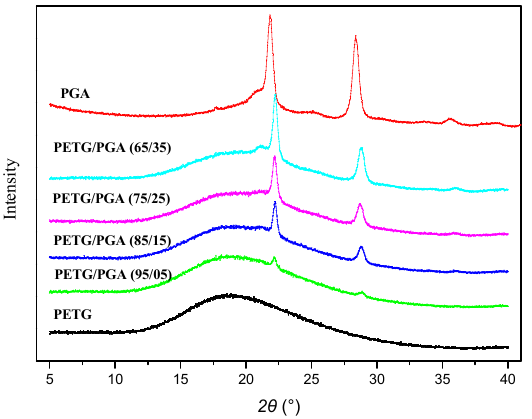
Figure 5. Wide-angle X-ray diffraction (WAXD) patterns of PETG, PGA, and PETG/PGA (y/z) samples.